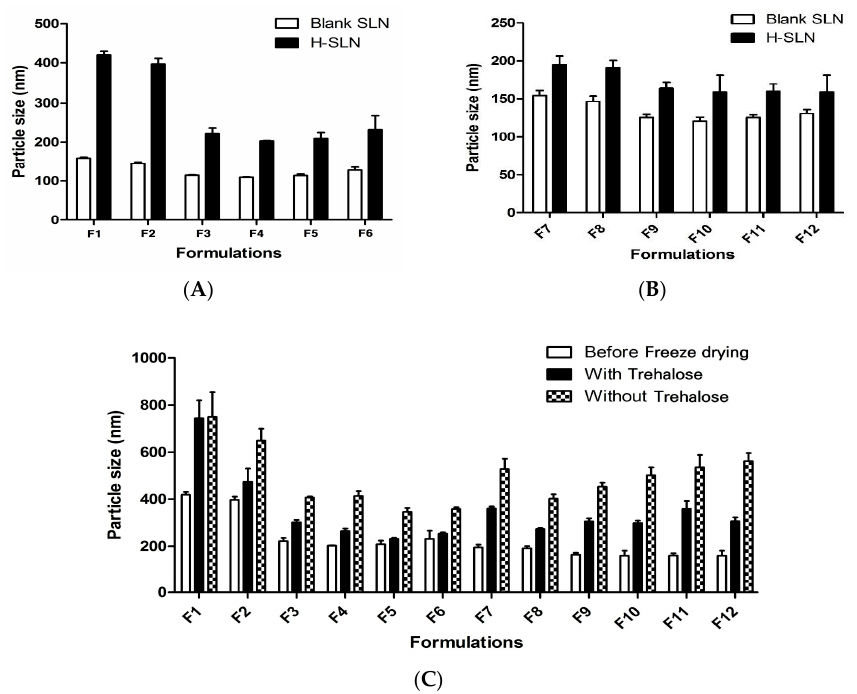
Figure 2. Effect of surfactant concentration in SLNs on the particle size. ( A ) Poloxamer 188 tailored SLNs; ( B ) Poloxamer 407 tailored SLNs. ( C ) Effect of the use of trehalose as a surfactant on the particle size. Data are expressed as the mean ± S.D. ( n = 3).